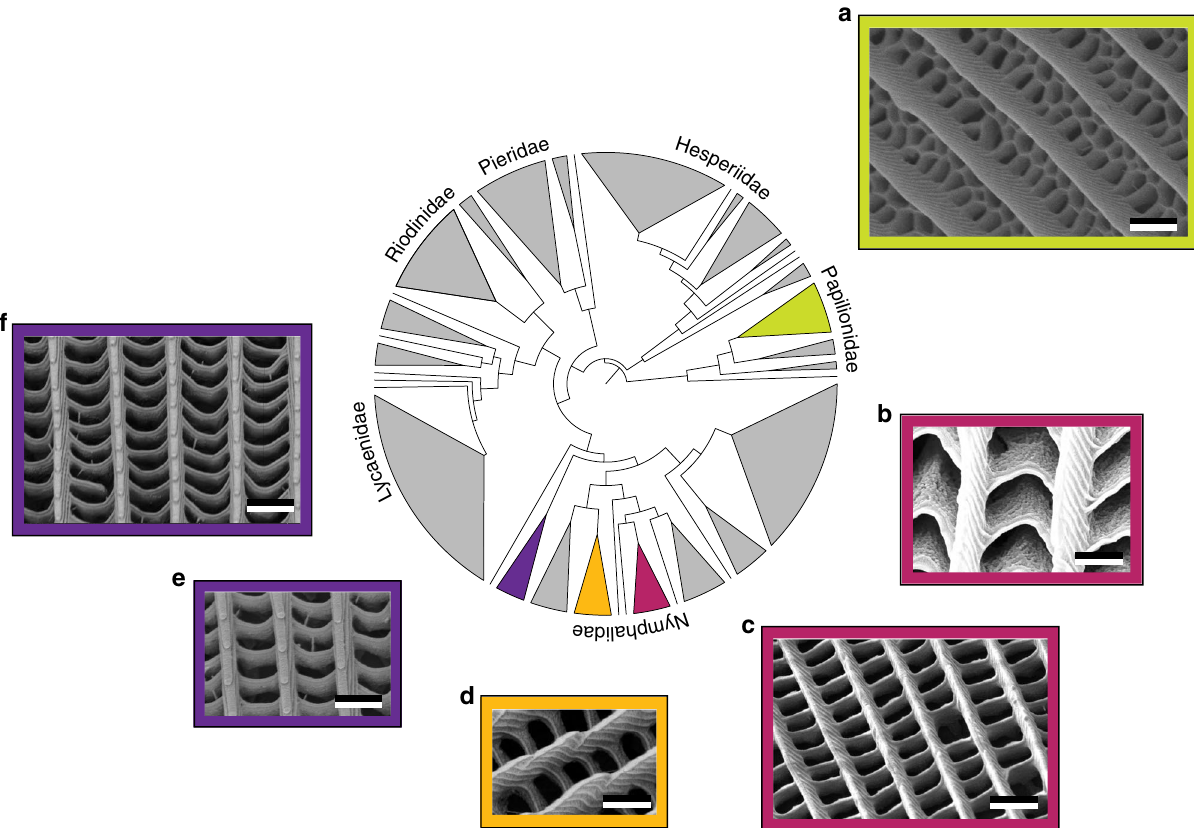
Fig. 2 Ultra-black butter fl y scales are widespread and morphologically diverse. A sub-family level phylogeny of butter fl ies adapted from ref. 22 showing the distribution of ultra-black coloration and SEMs of the underlying nanostructures. Note the variation in hole shape and size including a honeycomb ( a ), large and small rectangles ( c – f ), and chevron-shaped holes ( b ). Subfamilies shown in gray have no known ultra-black representatives. All scale bars are 1 µ m. Color of frames corresponds to color of sub-family on the phylogeny. Additional images in Supplementary Fig. 1. Species: a Trogonoptera brookiana (male), b E. chlorocroa , c C. antinoe , d H. doris , e E. dufresne , f E. klugi